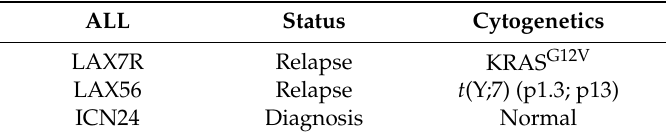
Table 1. Status and cytogenetics of the B-ALL